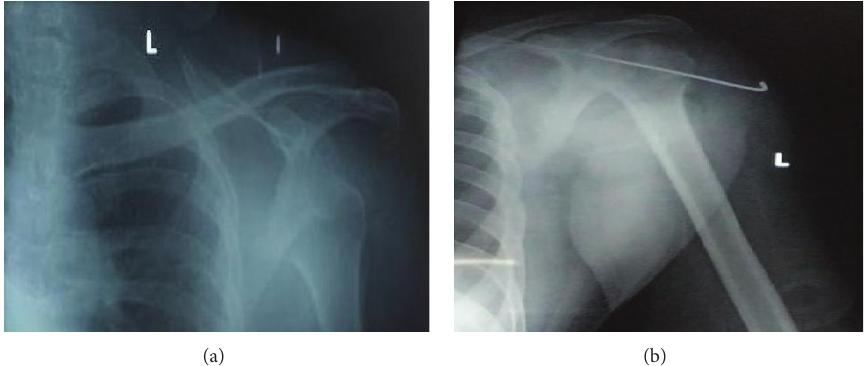
Figure 2: Radiographs of left anterior dislocation of shoulder (preoperative and postoperative).